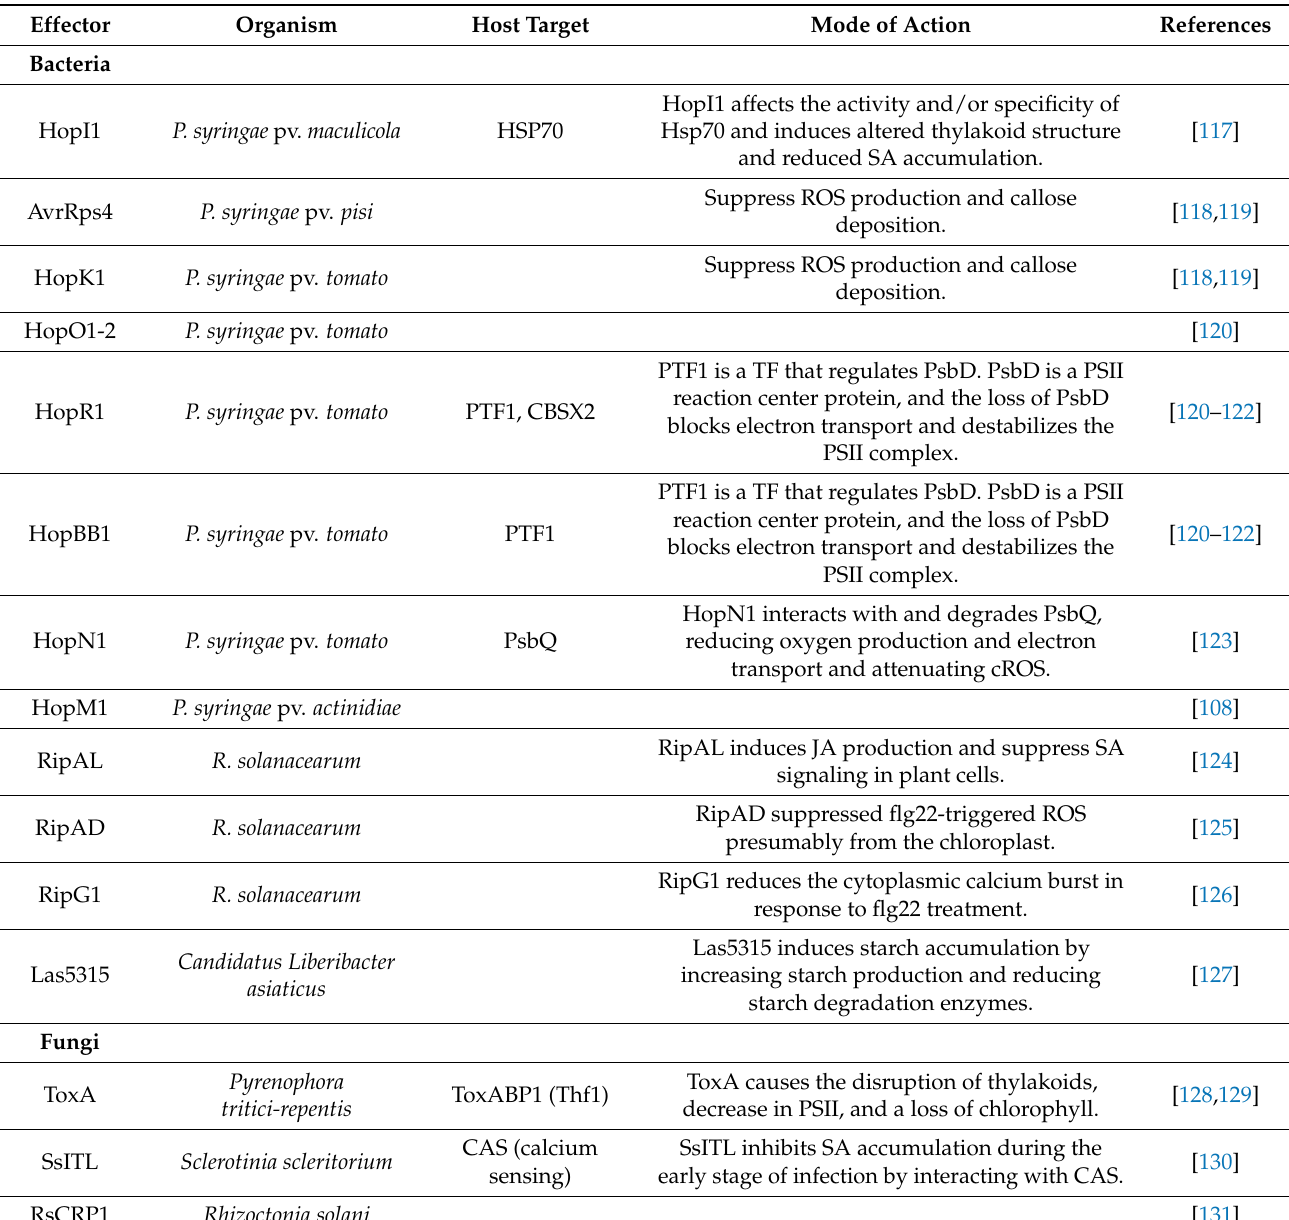
Table 2. Effectors that localize to the